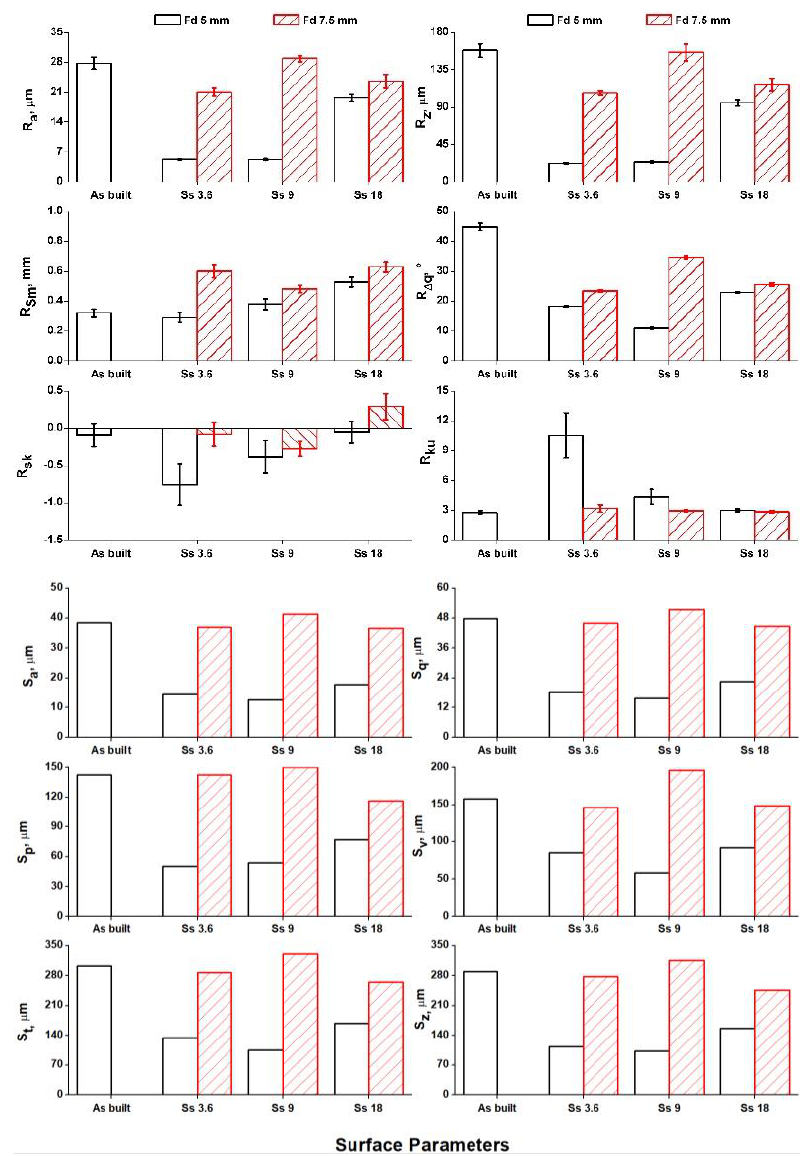
Figure 11. Surface profiles of as-built and treated samples.